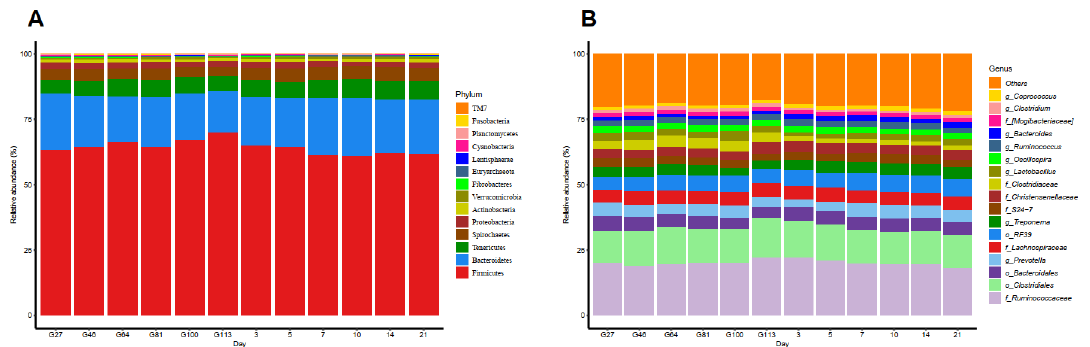
Figure 2. The bacterial composition in the perinatal sow feces samples determined by polymerase chain reaction amplification and 16S rRNA pyrophosphate sequencing. ( A ) The relative abundance of bacterial compositions at the phyla level of the bacteria in the feces sample. ( B ) The relative abundance of horizontal bacterial compositions at the genera level in fecal samples.